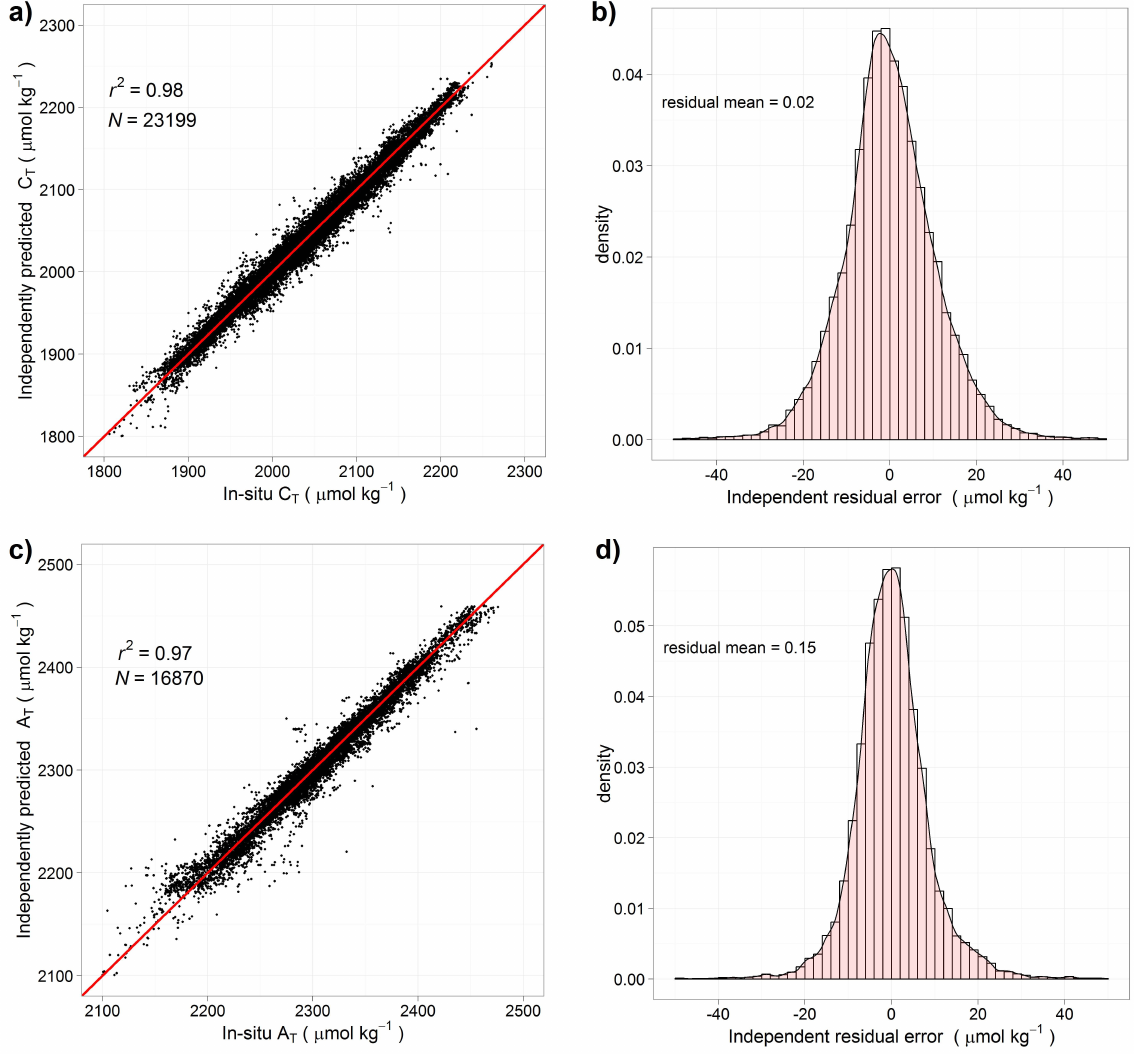
Fig. 13. Global independent test (SIT) predictions versus in situ measurements and residual error density distribution for optimal (a–b) C T and (c–d) A T SOMLO configurations. r 2 is r -squared correlation, and N is number of